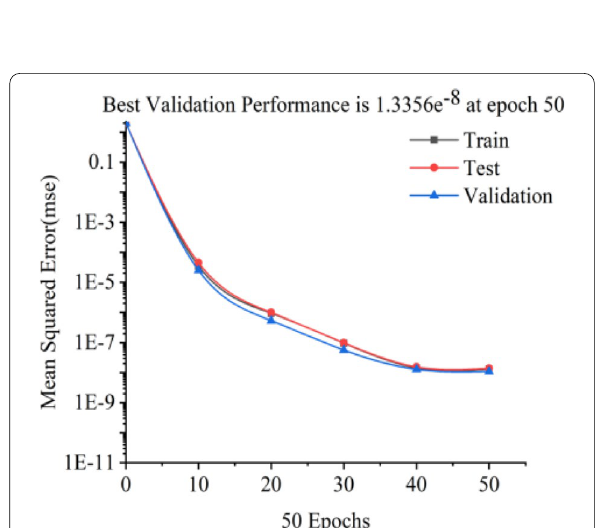
Figure 12 Bayesian network training sample fit